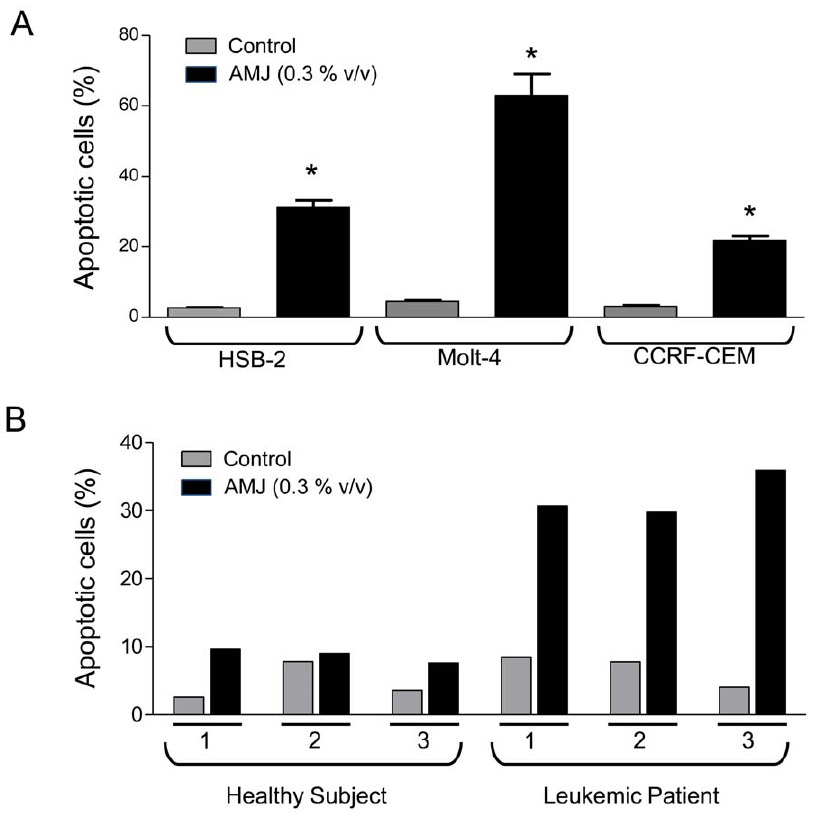
Figure 5. AMJ induced selective pro-apoptotic effects in different human leukemia cells and human primary lymphoblastic leukemia cells. (A) Pro-apoptotic effect of AMJ was assessed on various human leukemia cells (HSB-2, Molt-4 and CCRF-CEM). Values are shown as means 6 S.E.M. (n=3); *, P , 0.05 versus respective control; (B) The apoptosis rate of untreated or AMJ-treated primary T-lymphocytes from 3 healthy subjects or lymphoblastic leukemia cells from 3 patients was assessed by flow cytometry using the annexin V-FITC/PI apoptosis assay. The bar graph shows the cumulative percentage of cells which are in apoptosis.